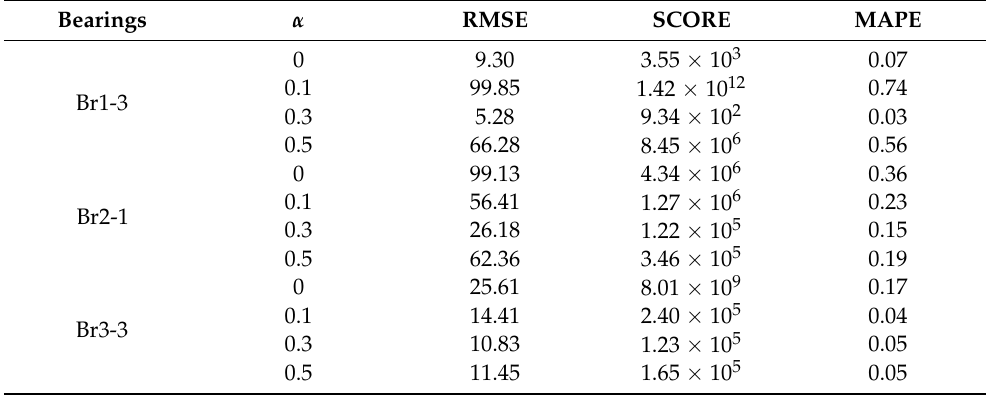
Figure 10. ( a ) RUL prediction of different α on Br1-3; ( b ) RUL prediction of different α on Br2-1; ( c ) RUL prediction of different α on Br3-3. Table 3. Evaluation indexes for different α